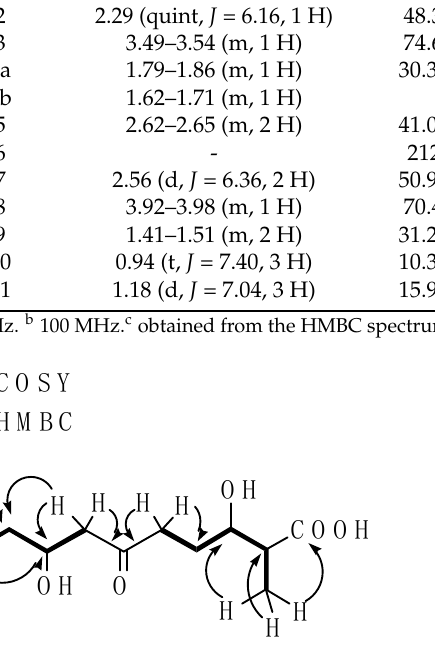
Figure 2. Key COSY and HMBC correlation of 1 .